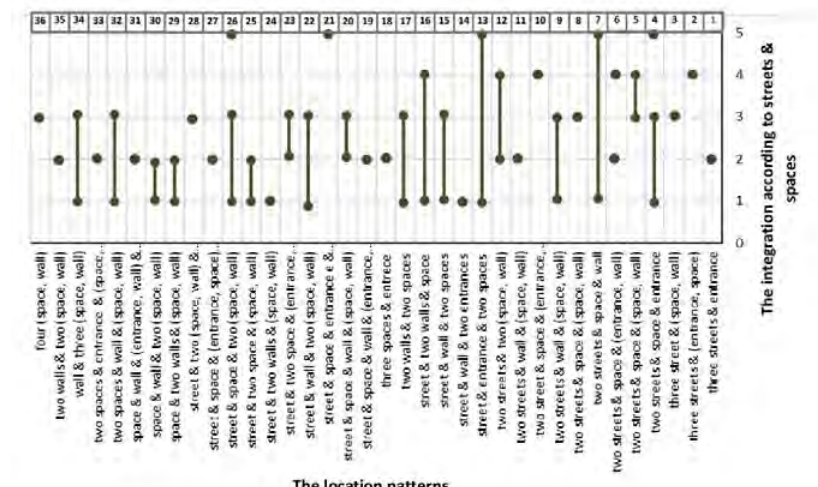
Figure 4. The relation between the space location patterns and the integration for space according to surrounding streets and